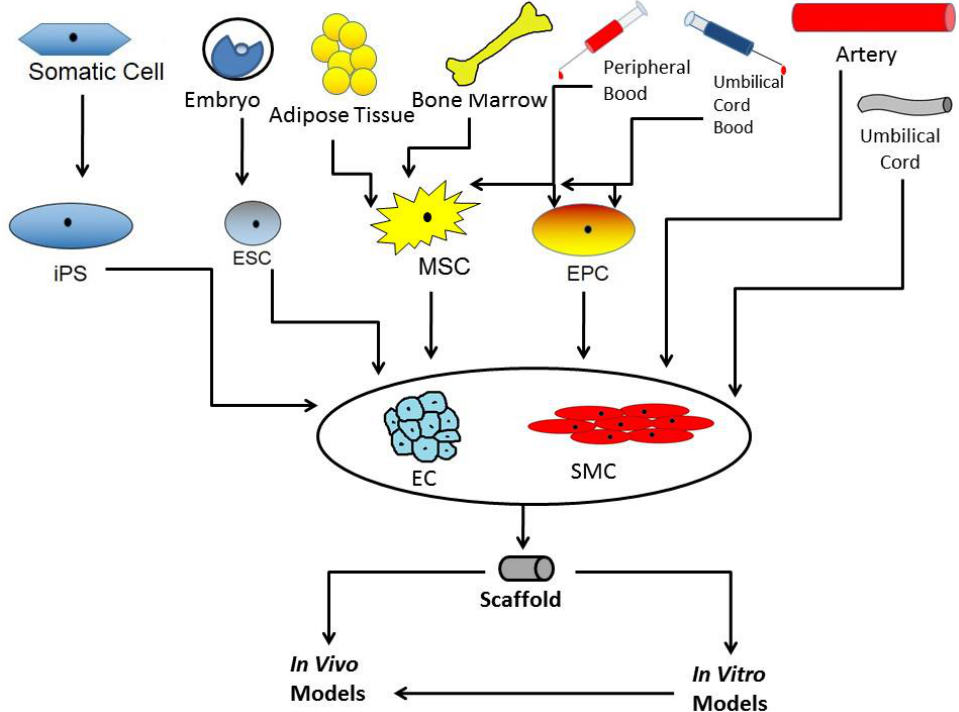
Figure 2. Cells used on grafts to promote vascular healing. The picture shows the different sources of cells used to promote vascular healing. Endothelial cells and smooth muscle cells can be obtained directly from primary tissue, e.g., arteries or umbilical cord or via differentiation of stem cells. Those stem cells can also be used directly on a graft. The cells can differentiate into the desired cell type and then be transplanted into animal